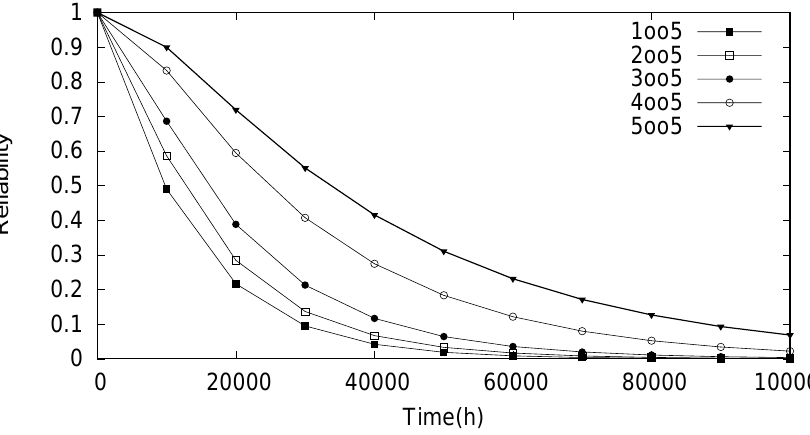
Figure 15. Reliability evaluation for scenario II.